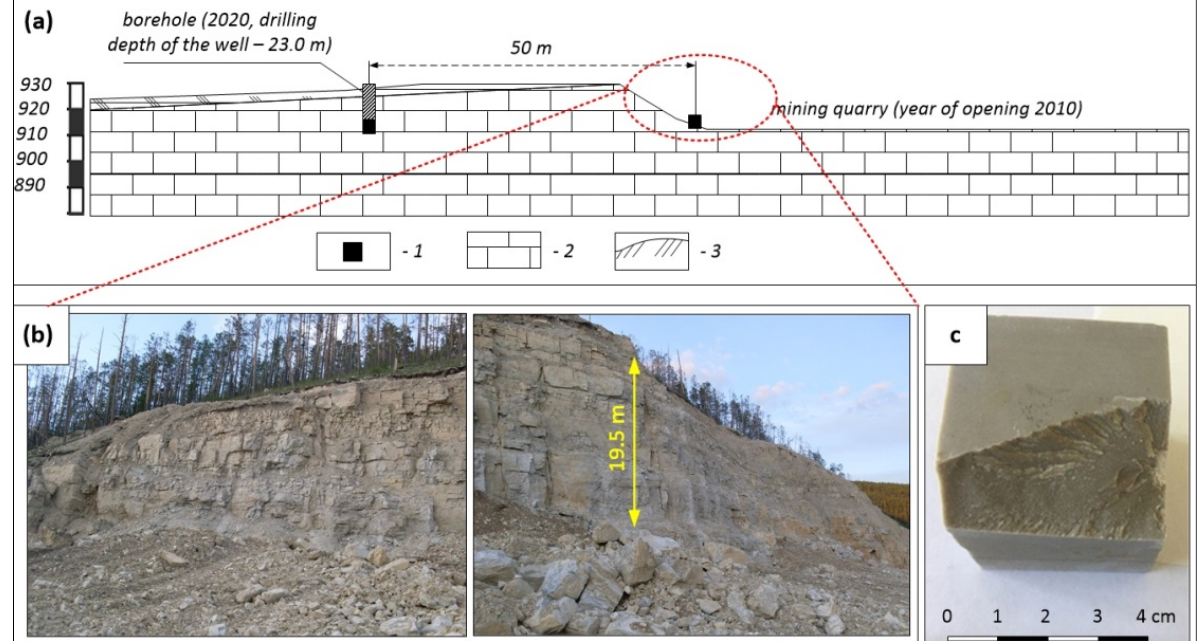
Figure 2. Scheme of the selection of limestone from the soil mass for analytical studies: ( a ) soil sampling scheme: 1—soil sampling points, 2—carbonate massif, 3—soil and vegetation layer; ( b ) general view of the wall of the mine from the base of which the soil sample was taken; ( c ) prepared cube-shaped specimen with cut-off top.